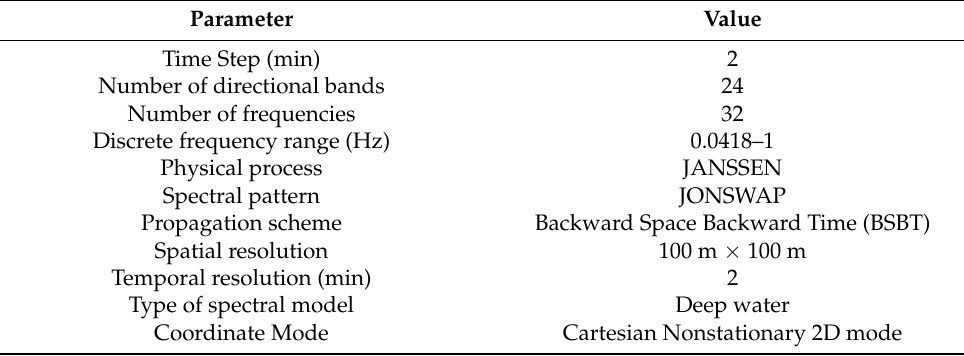
Table 2. SWAN model parameter